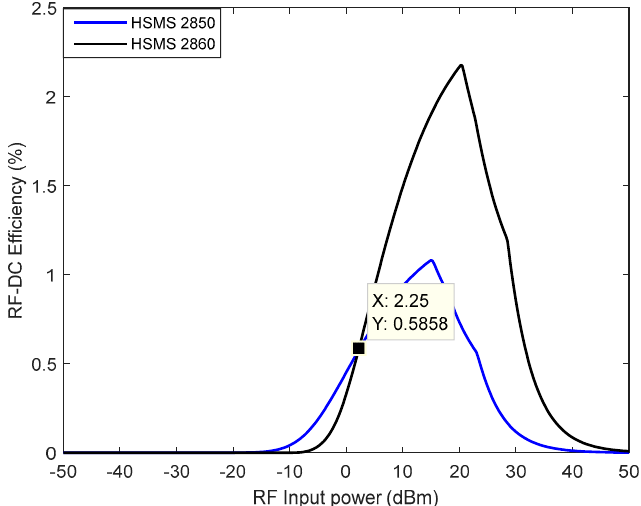
Figure 11. Comparison of the detection threshold of the diodes.